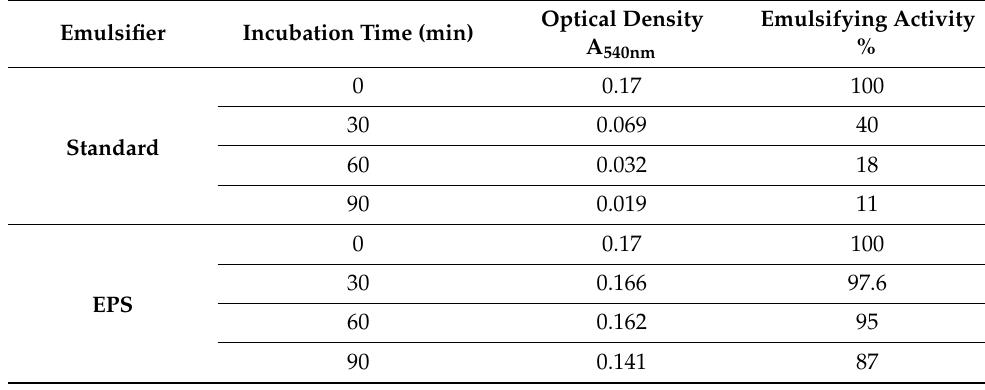
Table 2. Emulsifying activity of CUI-P1 exopolysaccharide